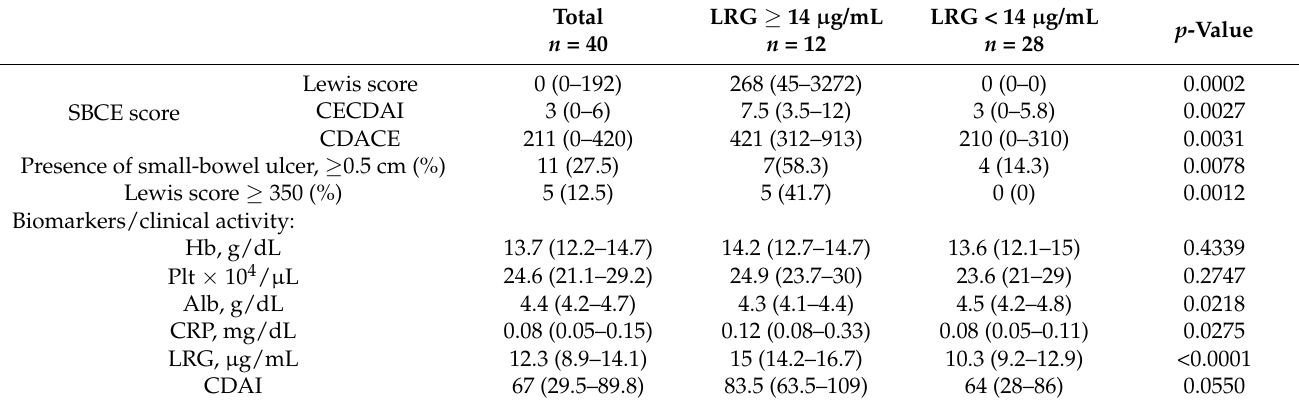
Table 3. Comparison of patients with LRG < vs. ≥ 14 μ g/mL.